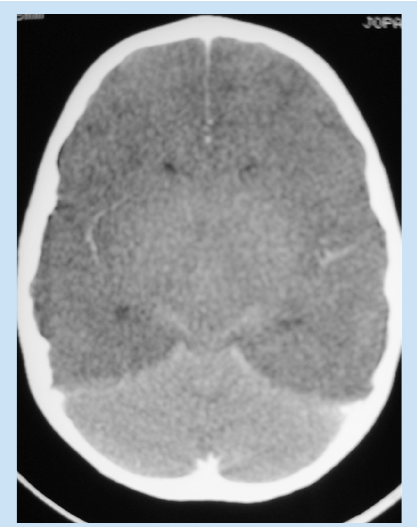
Fig. 1. White cerebellum sign. There is global hypodensity of the supratentorial brain with relative hyperdensity of the infratentorial compartment. There is also obliteration of the surface and central CSF spaces in keeping with the severe